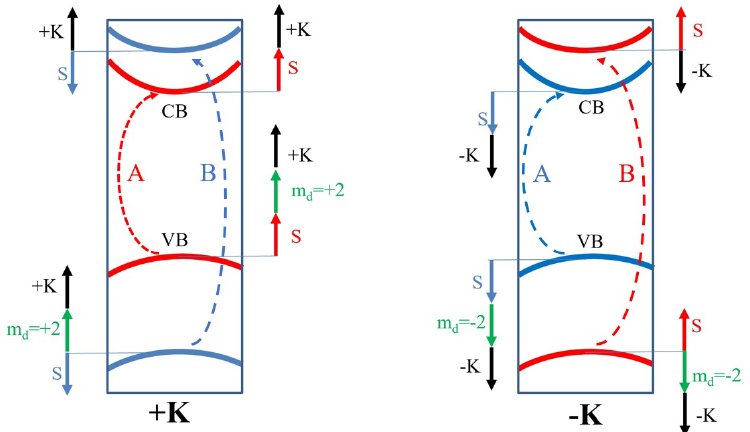
Figure 1. Schematic structure of spin-split bands in monolayer MX 2 + K / − K valleys. Respective A/B excitonic transitions are shown as dashed arrows. Additional solid arrows denote different contributions to the + K and − K valleys’ responses to magnetic fields. The solid blue and red arrows show the bare electron Zeeman contribution in magnetic field (cid:126) B = ( 0,0, B z ) ; the green—the atomic orbital Landé contribution and the black ones—the valley Zeeman